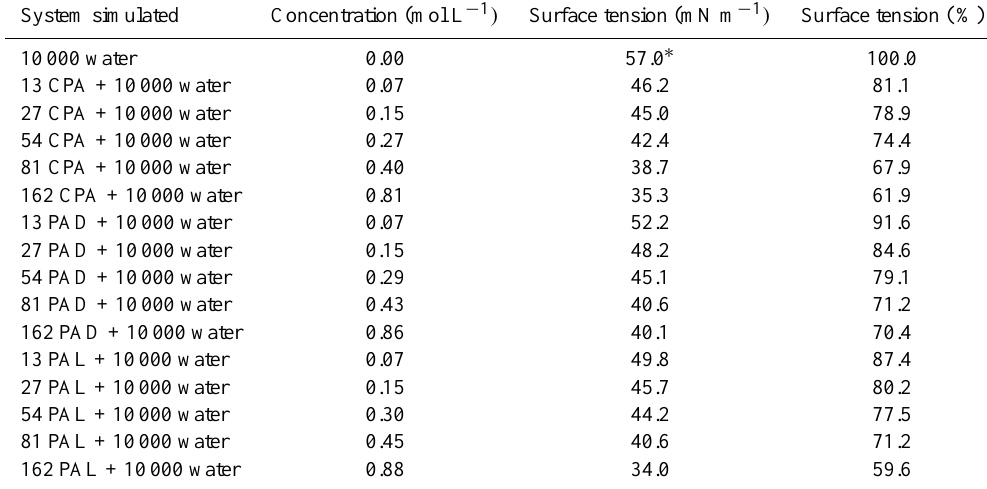
Table 2. Surface tension for the systems simulated.